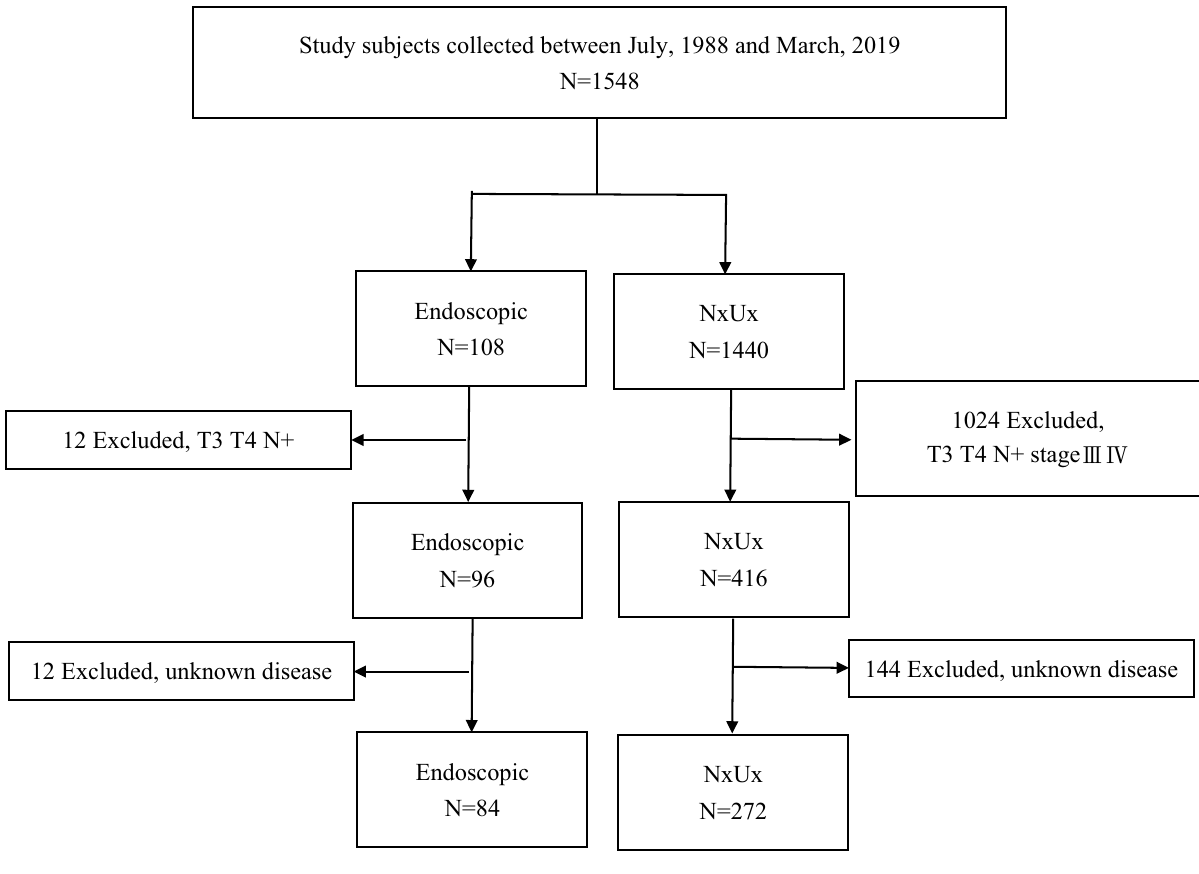
Figure 1. Flow diagram of case recruitment